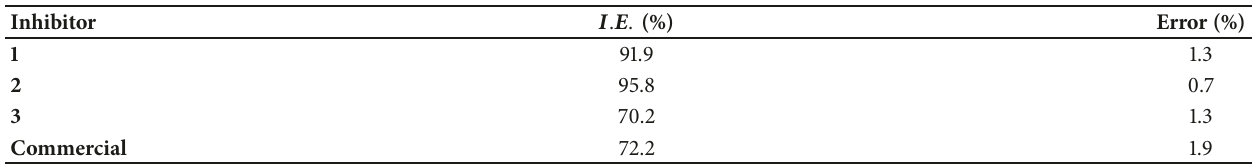
Table 1: Inhibitor efficiencies to carbon steel in 1.0 mol L – 1 HCl solution containing 250mg L – 1 of commercial and proposed inhibitors after immersion for 24 h at 25 ∘ C.